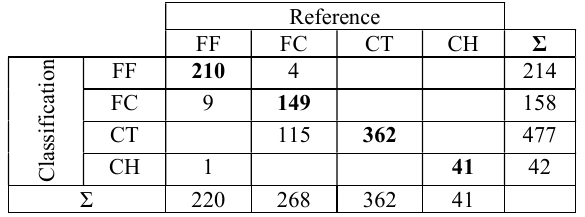
Table 5 . Matrix of confusion of the C5.0 algorithm.